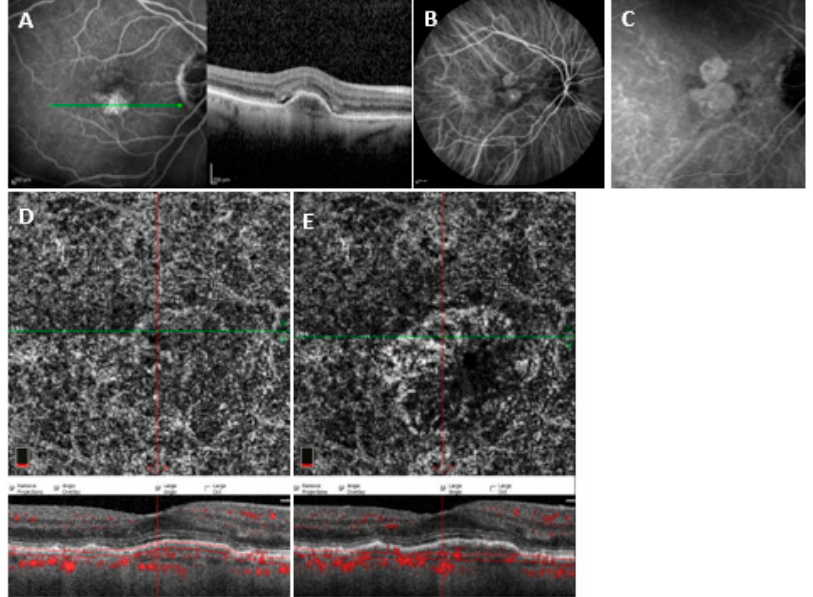
Figure 2. ( A ) SD-OCT crossing through the lesion showing a fibrovascular PED. ( B ) Early indocyanine green angiography. ( C ) Late indocyanine green angiography with late hyperfluorescent plaque. ( D ) En face and cross-sectional 3 × 3 mm 2 SD-OCTA with ANgiovue automated segmentation showing no distinctable flow. ( E ) En face and cross-sectional 3 × 3 mm 2 SD-OCTA with Angiovue corrected manual segmentation showing a distinct neovascular complex